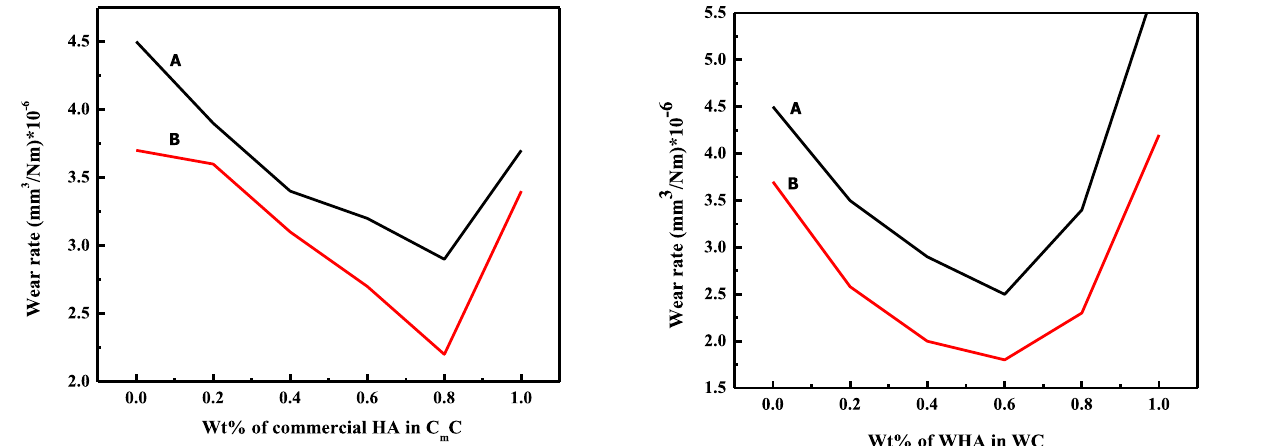
Fig. 7 Wear rate vs. percent amount of the fi ller in WC A dry and B wet condition during wear experiment conducted at 2 N applied load and 300 m sliding distance at room temperature